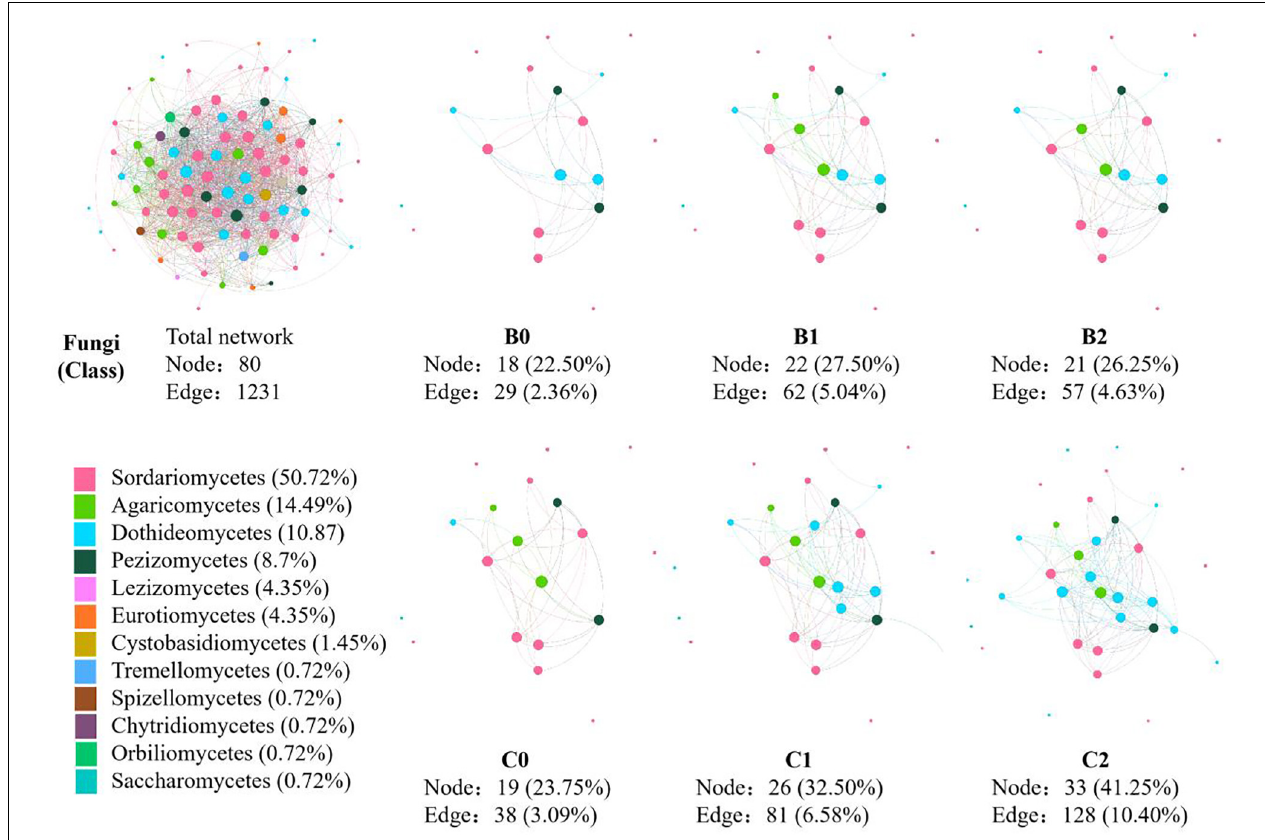
FIGURE 4 | The co-occurrence pattern of total fungal community and each sub-network fallowing co-inoculation of Bradyrhizobium japonicum 5038 and Bacillus aryabhattai MB35-5 in black and cinnamon